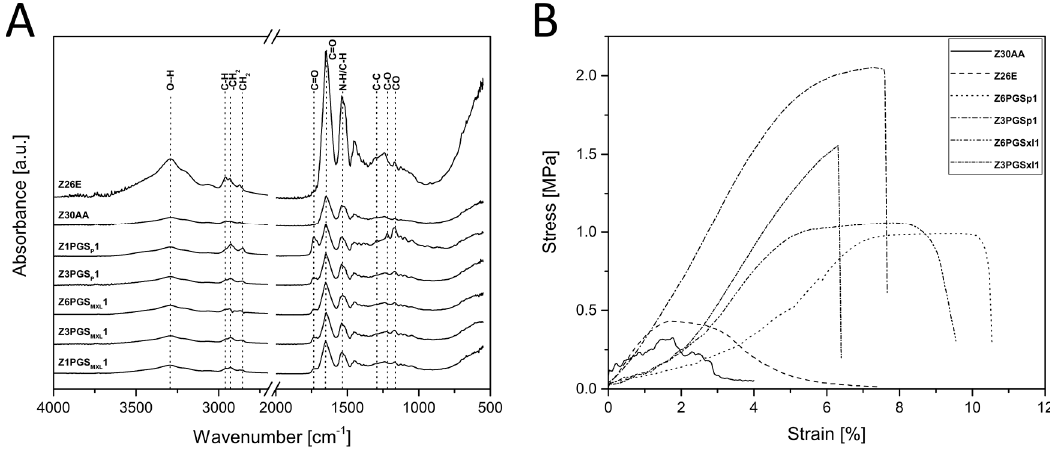
Figure 5. Physiochemical properties: ( A ) FTIR spectra of all produced fiber mats; ( B ) stress-strain curves of all fiber mats.